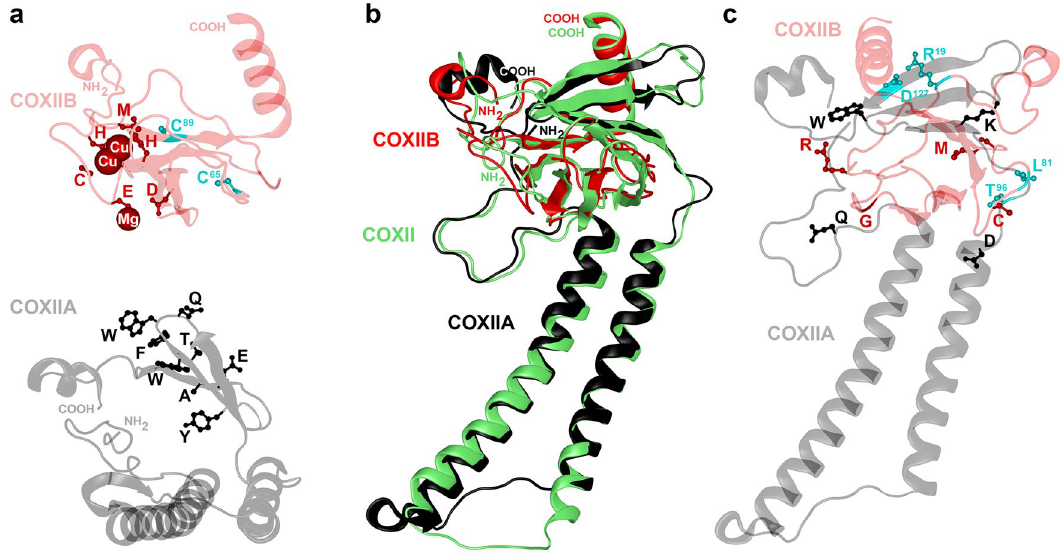
Figure 5. Ribbon diagrams of the predicted three-dimensional structures of COXIIA, COXIIB and their complex in D. tejensis sp. nov. Sequences of the analysed proteins are shown in Supplementary Fig. S8. The folding of split and canonical COXIIs was modelled on the crystal structures of bacterial (PDB accession numbers: 3HB3, 1M56, and 4TXV), yeast (6T15) and bovine (1OCZ) cytochrome c oxidases. ( a ) Tertiary structures of COXIIA and COXIIB. Amino acid residues of the COXIIA “haem patch” are shown in black; COXIIB residues chelating magnesium and mixed-valence copper ions in the Cu A centre are shown in red; unique to Dielis Cys residues flanking the Cu A centre are in blue. COXIIA is pictured in a plane view approximately perpendicular to its projections in the next panels. ( b ) The alignment of the tertiary structures of the D. tejensis sp. nov. COXIIA (black), COXIIB (red) and undivided COXII of S. bicincta (green). ( c ) The most stable COXIIA-COXIIB docking decoy (-24.3 kcal/mol). Selected evolutionarily conserved residues involved in docking interactions (Supplementary Fig. S8) are shown in black (COXIIA) and red (COXIIB), supernumerary Thr unique to Dielis , its interactor Leu, and a pair of residues Asp and Arg, predicted to form a salt bridge between COXIIA and COXIIB, are marked in